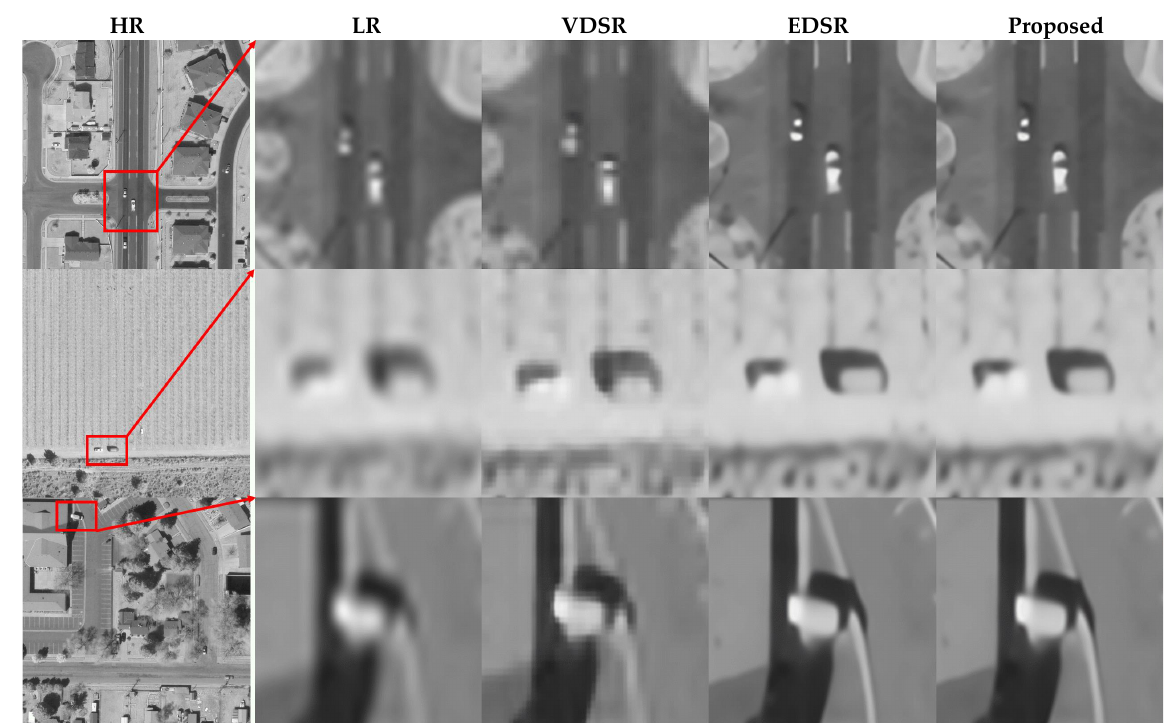
Remote Sens. 2022 , 14 , x FOR PEER REVIEW Figure 4. Visual comparisons: IR images from VEDAI-IR dataset. Figure 4. Visual comparisons: IR images from VEDAI-IR dataset.